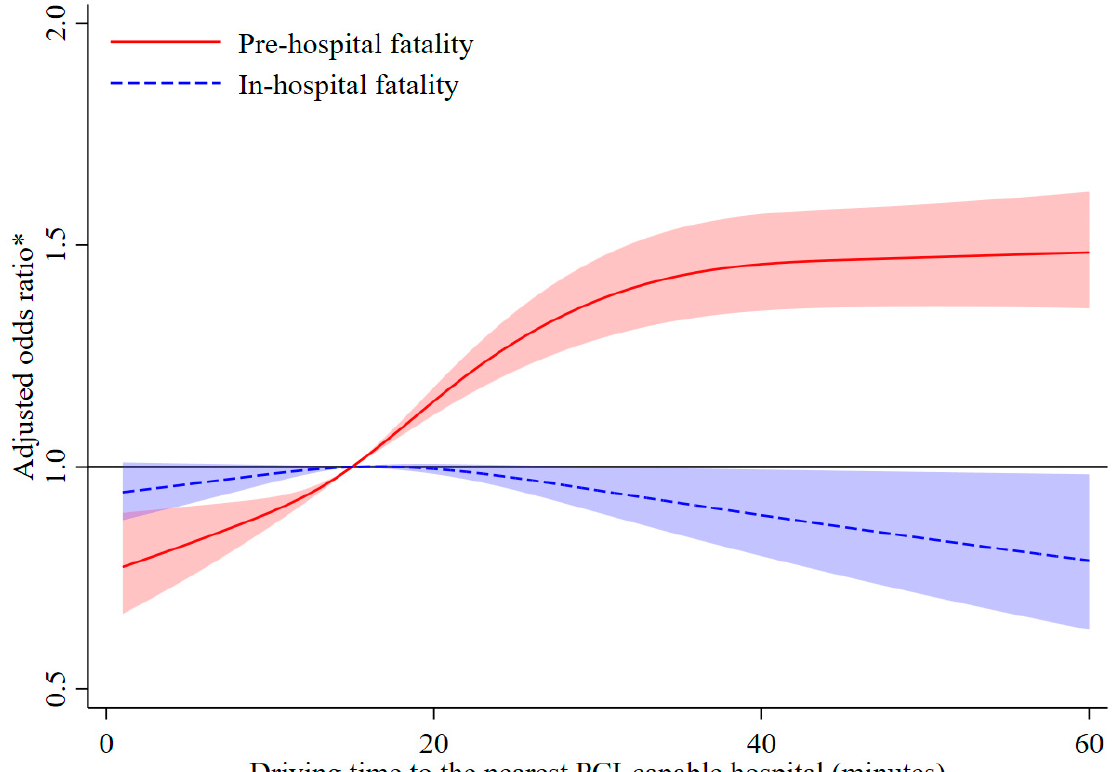
Figure 3. Restricted cubic spline analysis for the association between driving time to the nearest percutaneous coronary intervention-capable hospital and the risk of pre-hospital fatality and in- hospital fatality among patients with acute myocardial infarction. * Model adjusted for age, sex, marital status, day of the week, year of the event, heart failure, stroke, years of education, per-capita disposable income at the district level, proportion of unemployed at the district level, prevalence of hypertension at the district level, prevalence of diabetes at the district level, prevalence of hyper- cholesterolemia at the district level, and prevalence of smoking at the district level. In the analysis of the association between driving time and in-hospital death, the model additionally adjusted for potential selection bias.